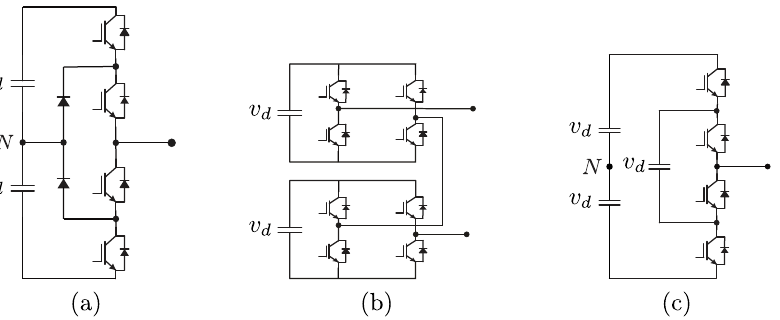
Figure 1. Conventional multilevel inverters (MLI) topologies: ( a ) neutral-point clamped (NPC), ( b ) cascaded H-bridge, ( c )